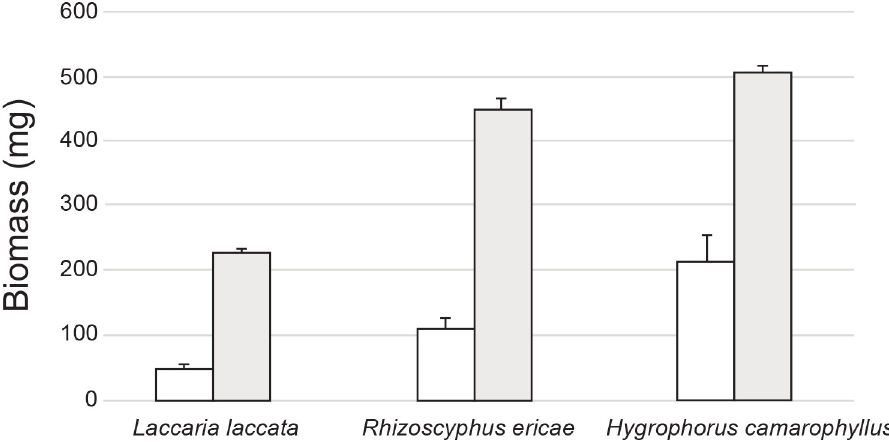
Fig 6. Biomass production for three mycorrhizal fungal species grown for three weeks in simulated process water. Average biomass production ± stdev for controls grown for one week in Basal Norkrans medium (white bars; n = 2), and the simulated process water treatment grown for one initial week in Basal Norkrans medium followed by three weeks in amine solution (grey bars; n = 3).